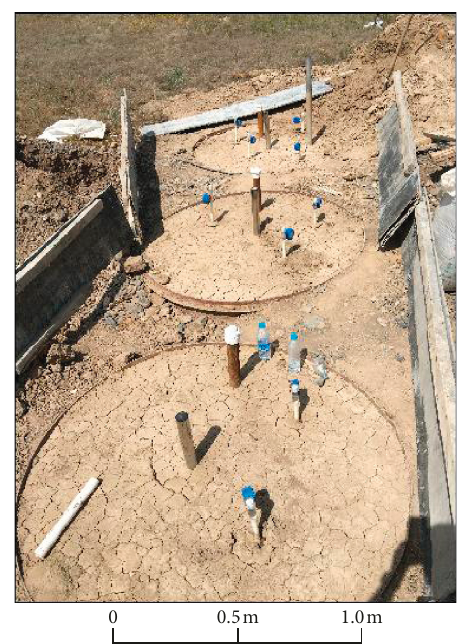
Figure 10: Hardening phenomena of the reclaimed soil with one- time compaction after a one-year maintenance period.